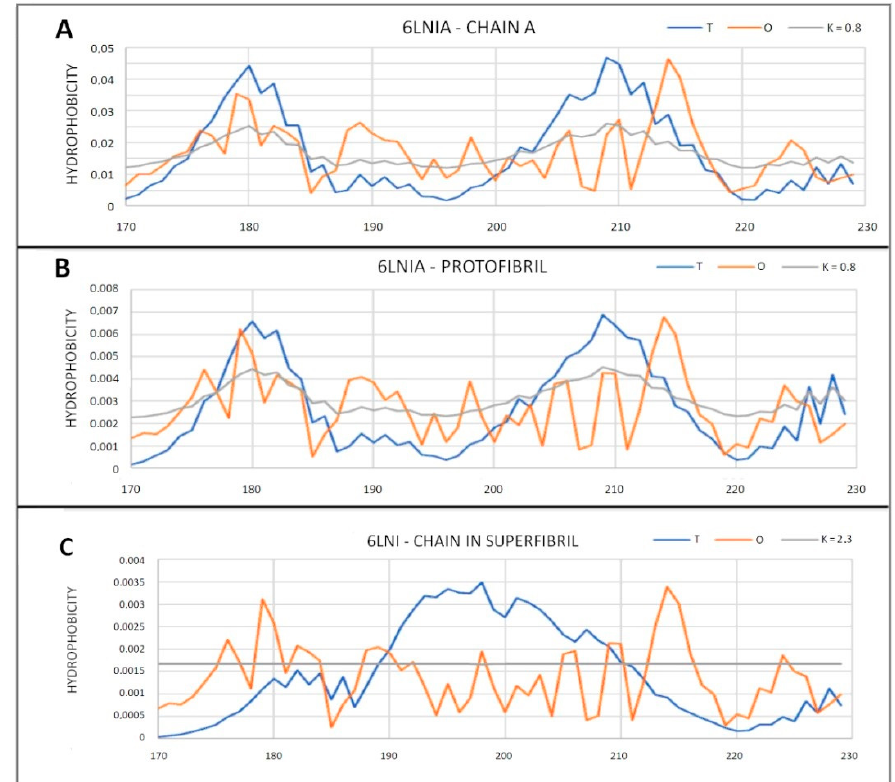
Figure 17. A set of profiles for amyloid showing a status significantly different from micelle-like with PDB ID 6LNI. ( A ) Individual chain; ( B ) status of chain in protofibril; ( C ) status in chain as part of super-fibril.